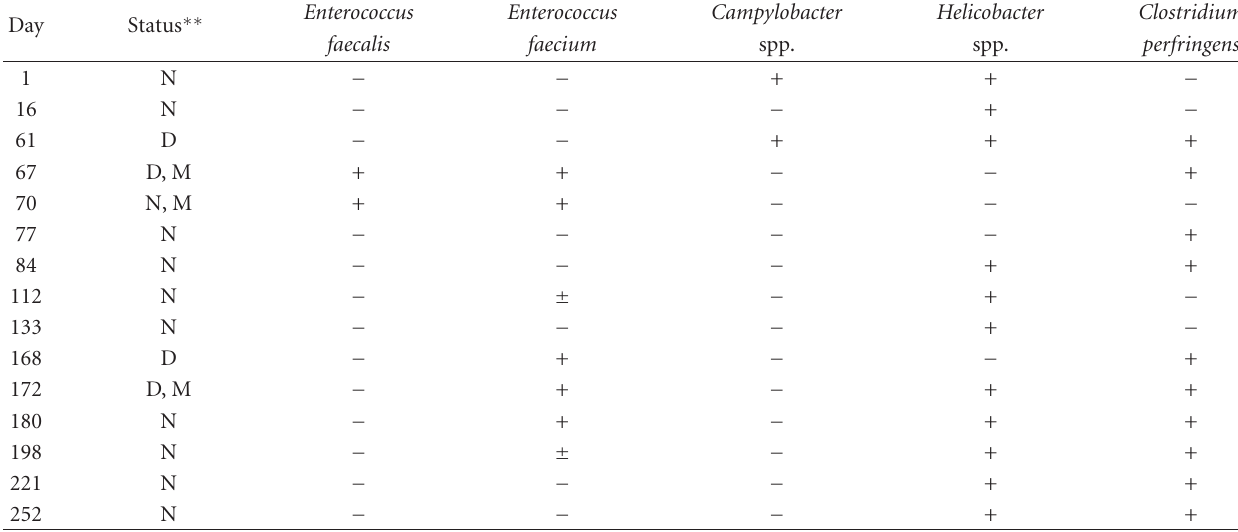
Table 3: Detection of potential pathogens in pet dog with two diarrheic episodes by standard PCR assay ∗